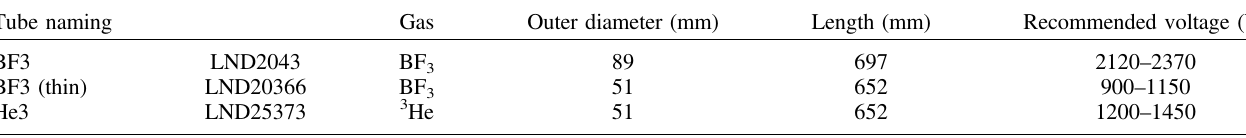
Table 1. Comparison of the different tubes used for testing a